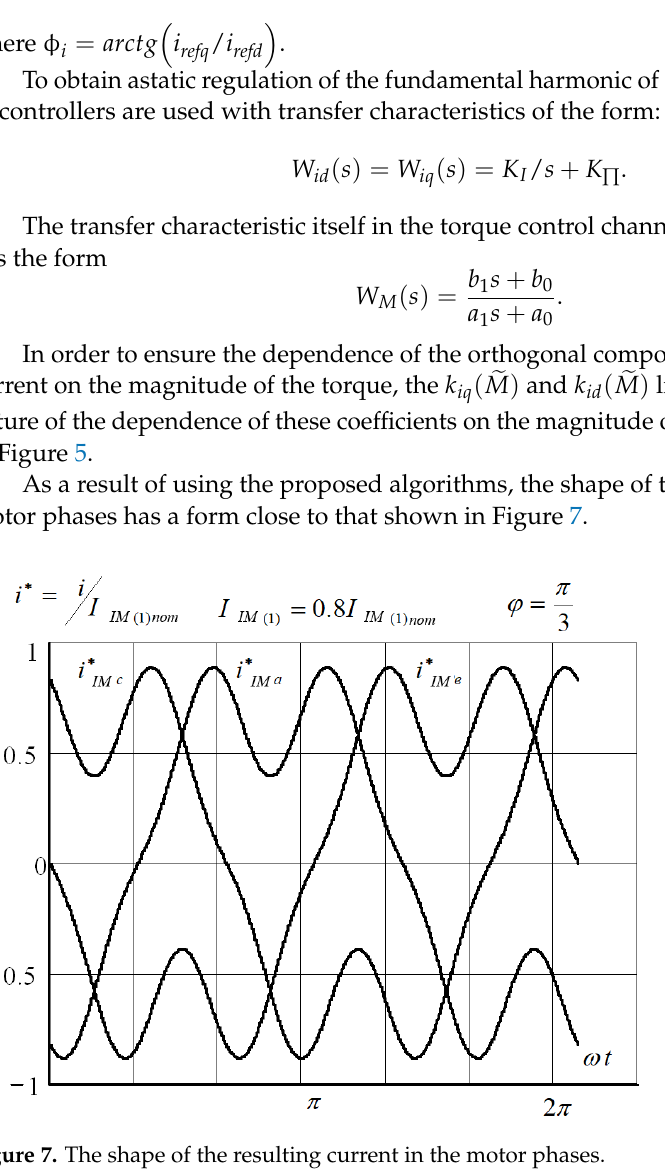
Figure 7. The shape of the resulting current in the motor phases.